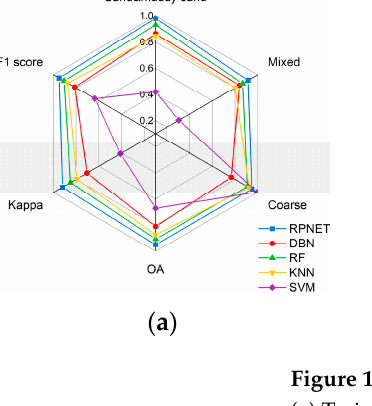
Figure 15. Comparison of different classifiers when the number of training samples decrease in S1.